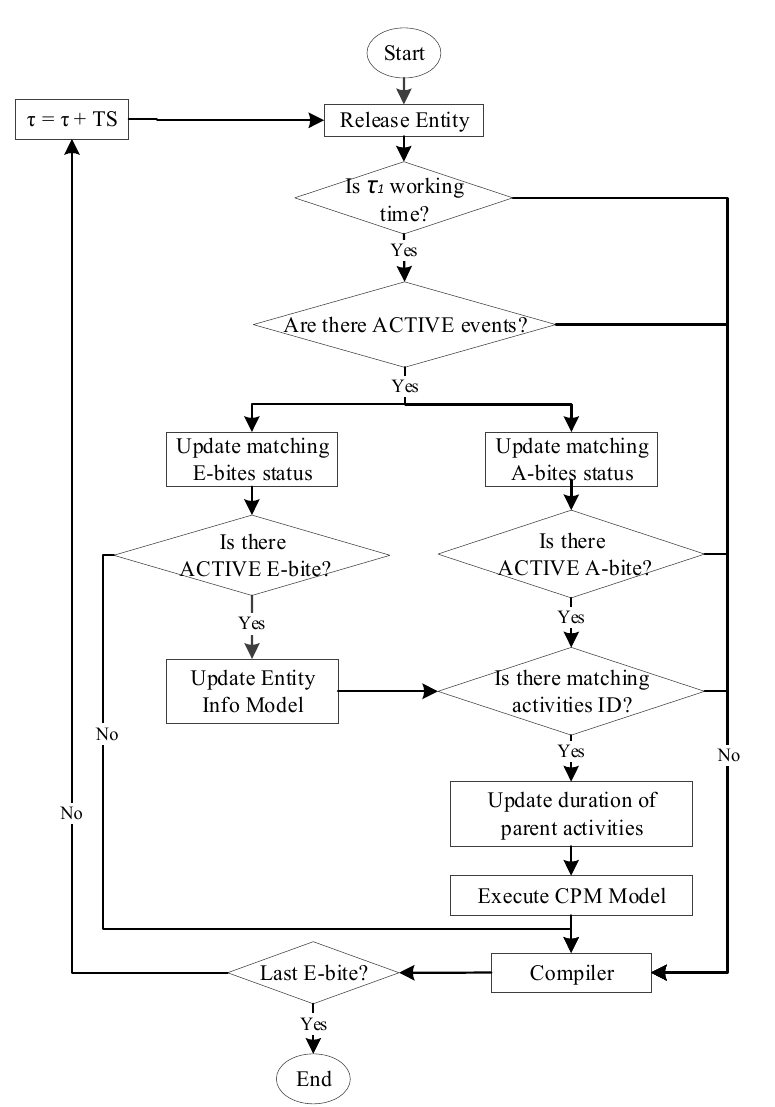
Figure 4. Data integration process.